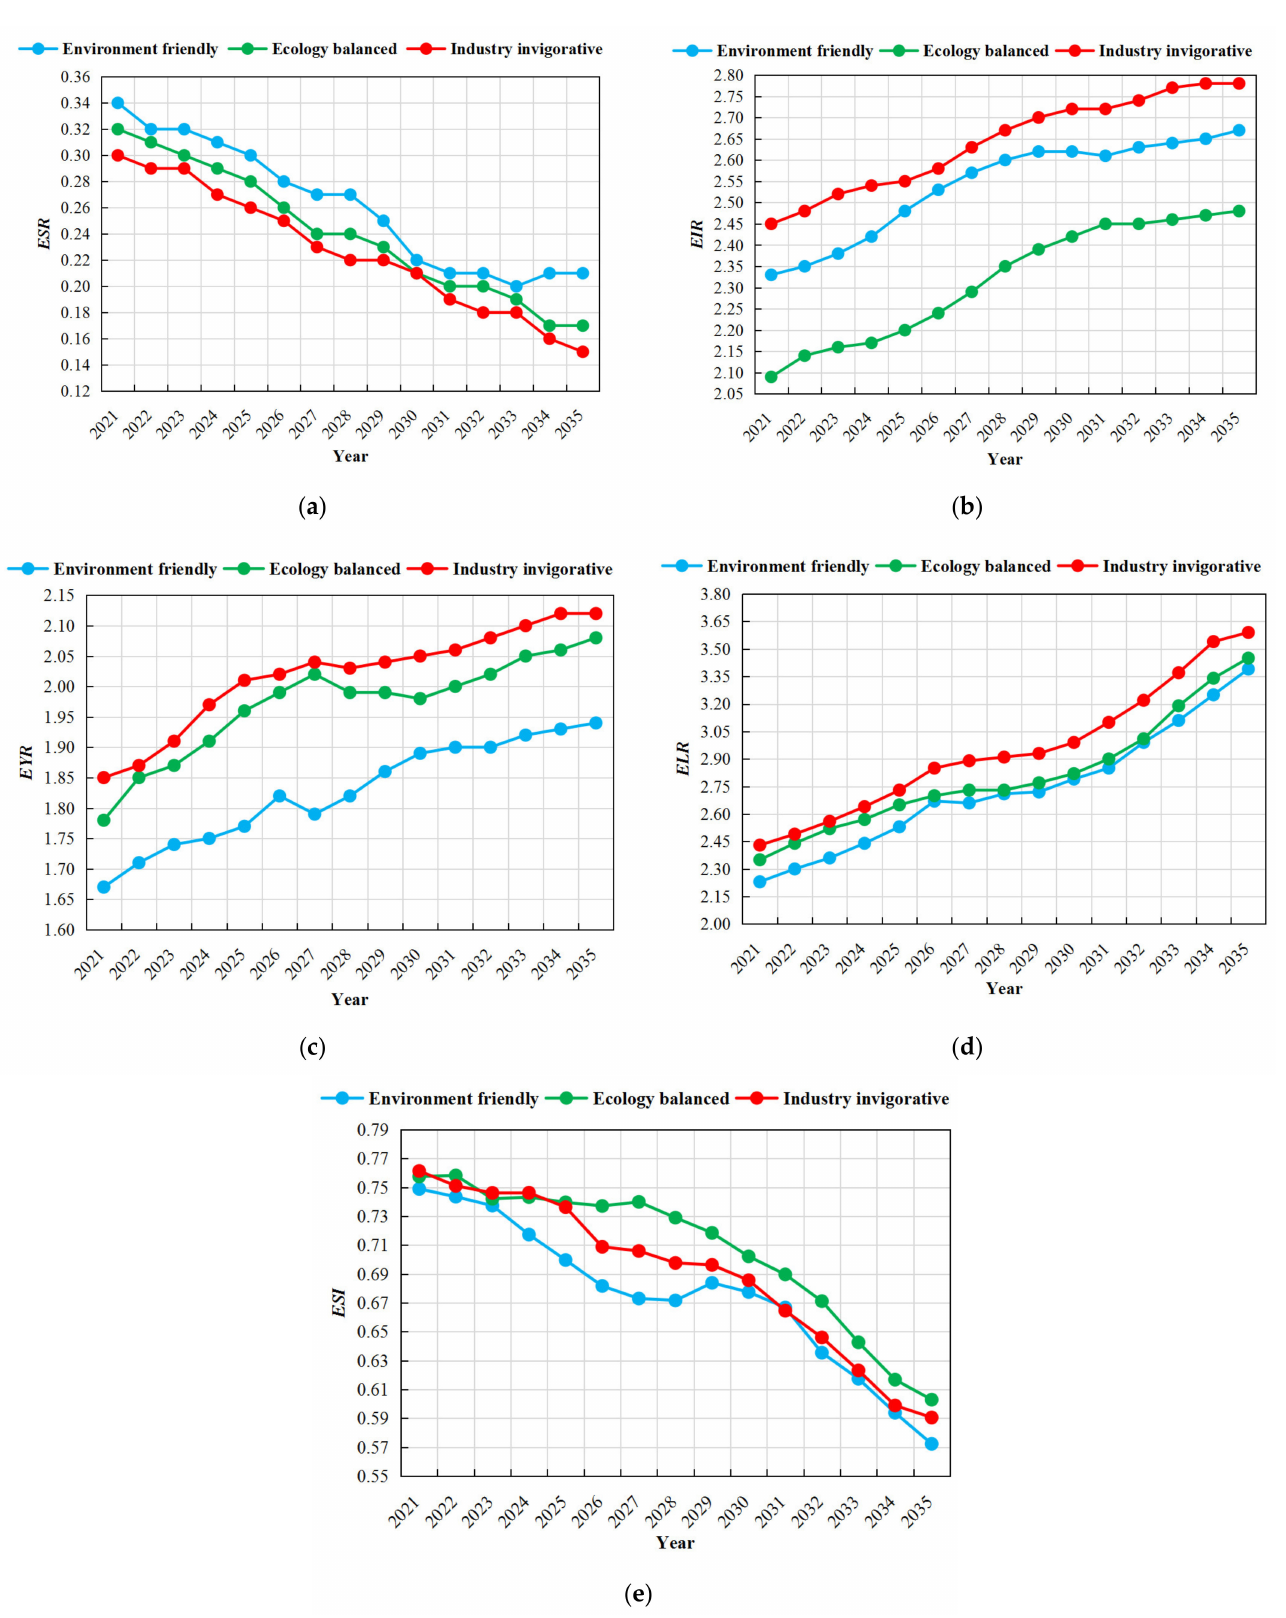
Figure 7. Dynamic emergy evaluation indices prediction of the village unit. ( a ) ESR prediction; ( b ) EIR prediction; ( c ) EYR prediction; ( d ) ELR prediction; and ( e ) ESI